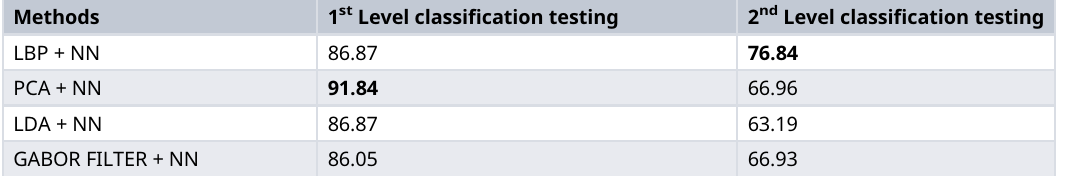
Table 4. Experimental results of NN variants. The best results are highlighted in